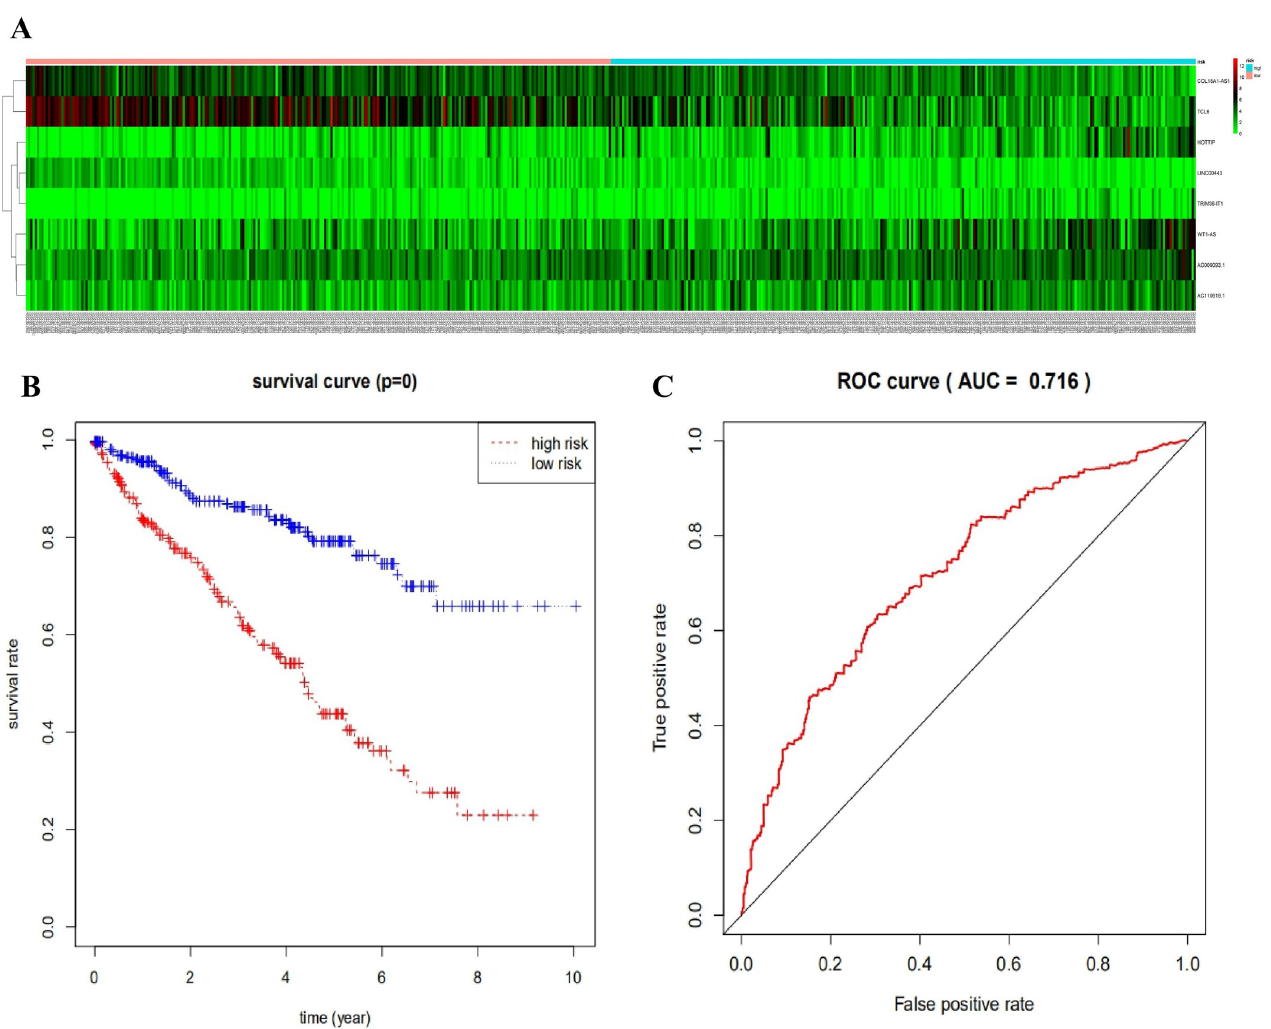
Fig 6. The prognosis of eight lncRNAs in patients with KIRC. (a). Risk heat map based on eight lncRNAs from 530 LUSC patients. (b). Kaplan-Meier curve analysis was performed on the overall survival rate of patients with KIRC using eight lncRNAs. (c). ROC curve analysis was performed on the eight prognosis lncRNAs. AUC: Area Under ROC Curve, ROC curve: Receiver operating characteristic